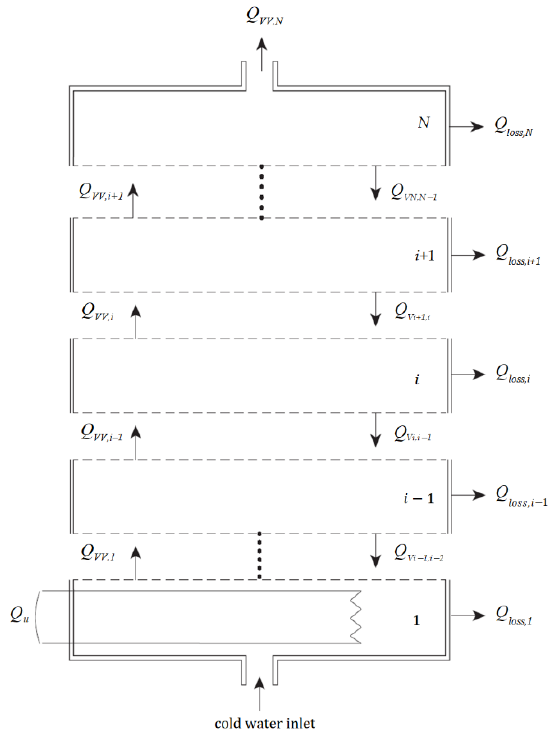
Figure 1. Diagram of an N -section tank with a spiral coil in its lower part [39].